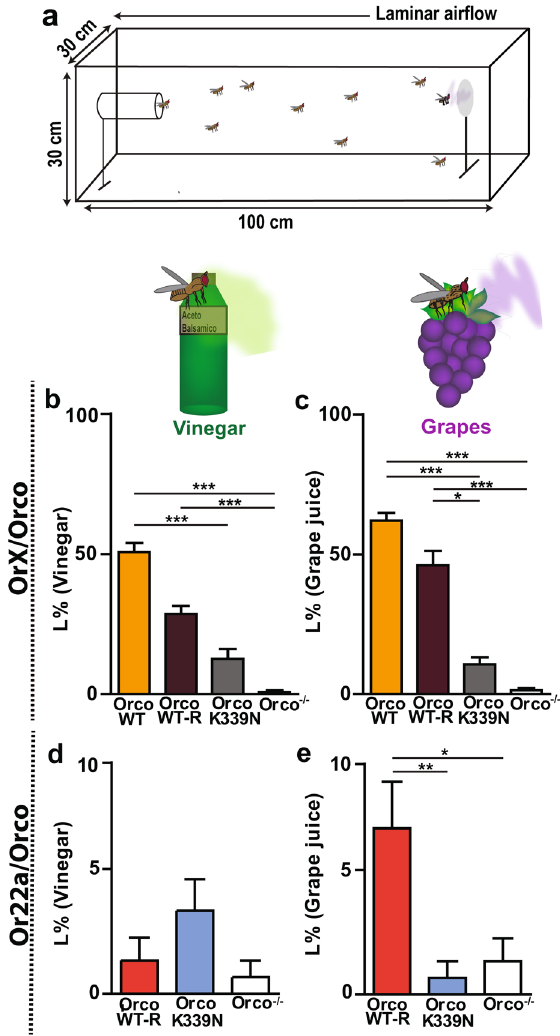
Figure 6. Effect of Orco CBS mutation on the odor odor-guided behaviour. (a) Schematic diagram of wind tunnel bioassay. Odor guided behavior is monitored as landing of Drosophila melanogaster on filter paper containing balsamic vinegar (10 –2 dilution) (left) or pure grape juice (right). (b , c) Landing percentage (L %) of OrX/Orco flies in OrcoWT, OrcoWT-R, OrcoK339N, and Orco -/- condition with vinegar (10 –2 dilution) (a) and pure grape juice (b) . (d , e) Landing percentage (L %) of Or22a/Orco flies in OrcoWT-R, OrcoK339N, and Orco -/- condition with vinegar (10 –2 dilution) (d) and grape juice (e) . For (d) not all the values were different from each other. n = 15 replicates, each replicate consists of 15 mated female flies. Kruskal–Wallis test with Dunn’s Multiple Comparison Test, * P < 0.05, ** P < 0.01, *** P < 0.001, otherwise not significant. Data given as mean ±